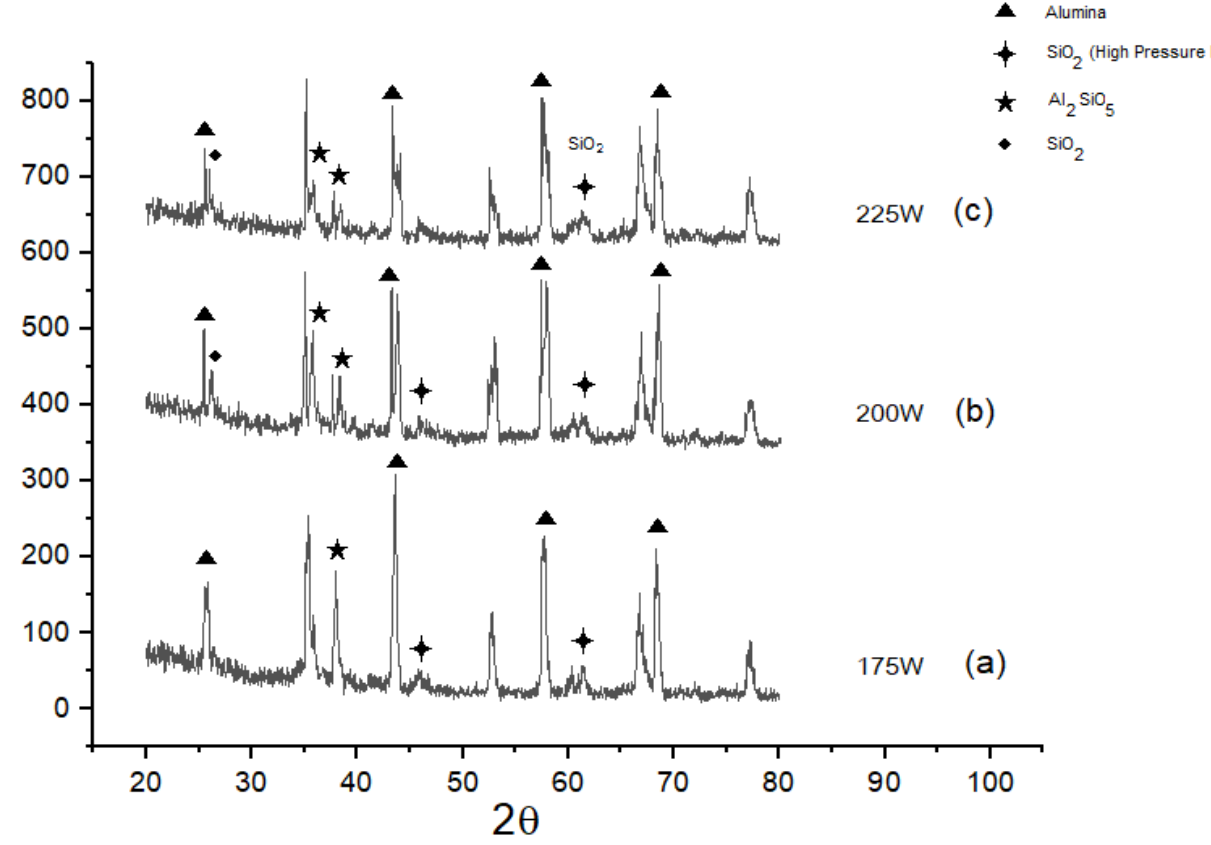
Figure 6. ( a ) XRD for Al 2 O 3 wt % 90, silicon carbide wt % 10 at 175 W laser power. ( b ) XRD for Al 2 O 3 wt % 90, silicon carbide wt % 10 at 200 W laser power. ( c ) XRD for Al 2 O 3 wt % 90, silicon carbide wt % 10 at 225 W laser power.